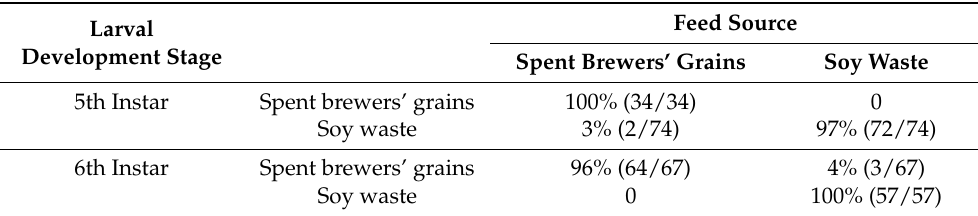
Table 1. Linear discriminant analysis (LDA) confusion matrix, percentage of correct classification. In brackets is the number of